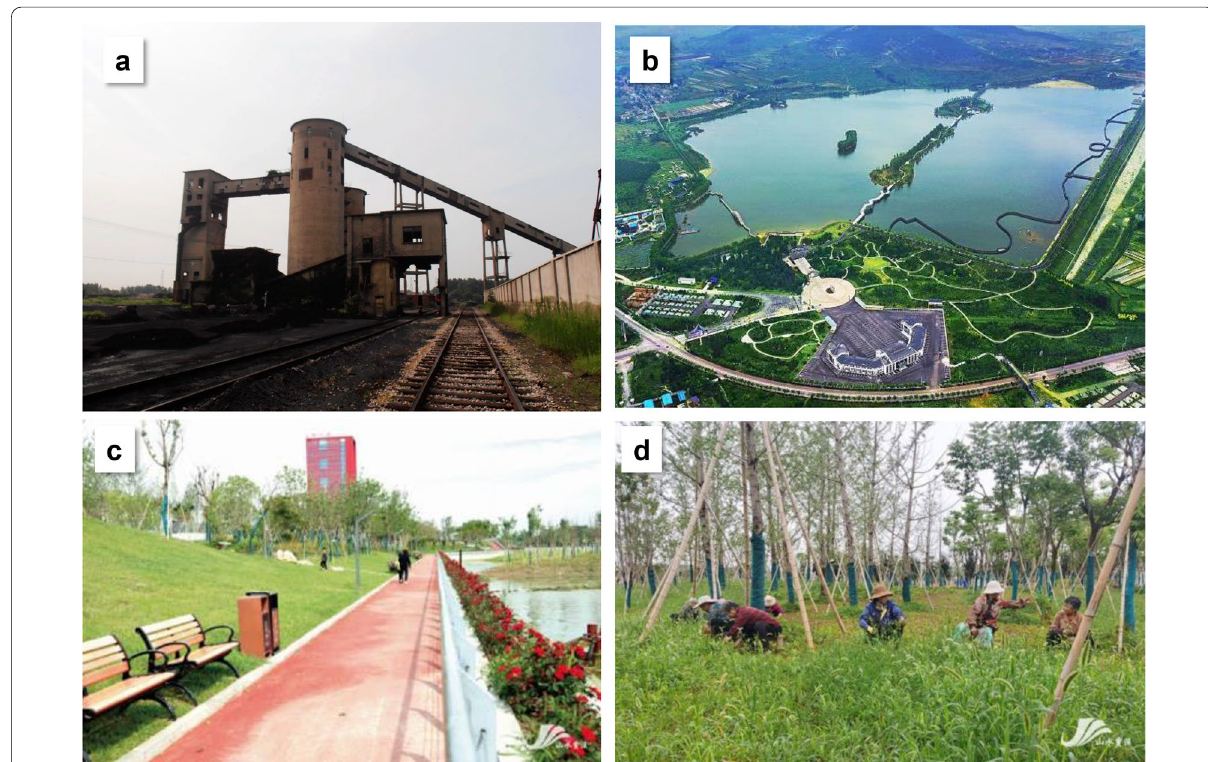
Fig. 3 Photos of a coal mine in operation (photo taken in the 1990s) and b coal mine after rehabilitation with ecological parks and artificial lakes, Dawu mining district; c , d ecological restoration zone (photos from http:// js. people. com. cn/): c embankment along artificial lake, and d reforestation in the planned forest